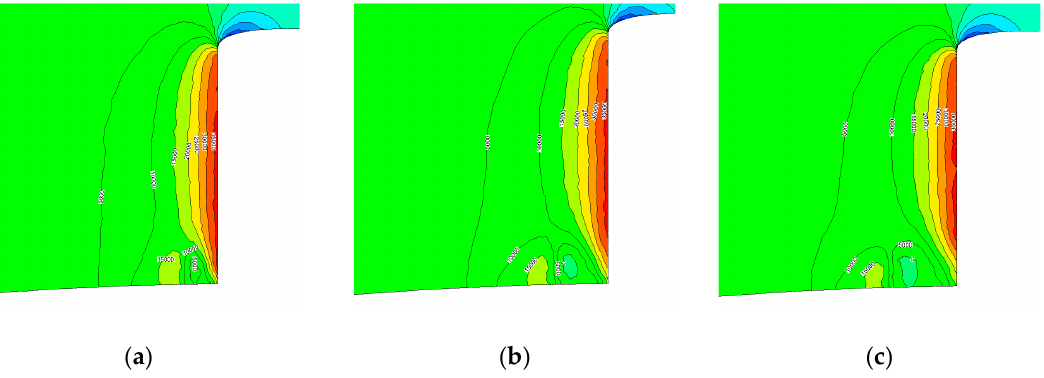
Figure 18. The contour map at the leading edge of Plane B of the model with triangular VGs at different distances. ( a ) 0.1c; ( b ) 0.15c; ( c ) 0.2c.